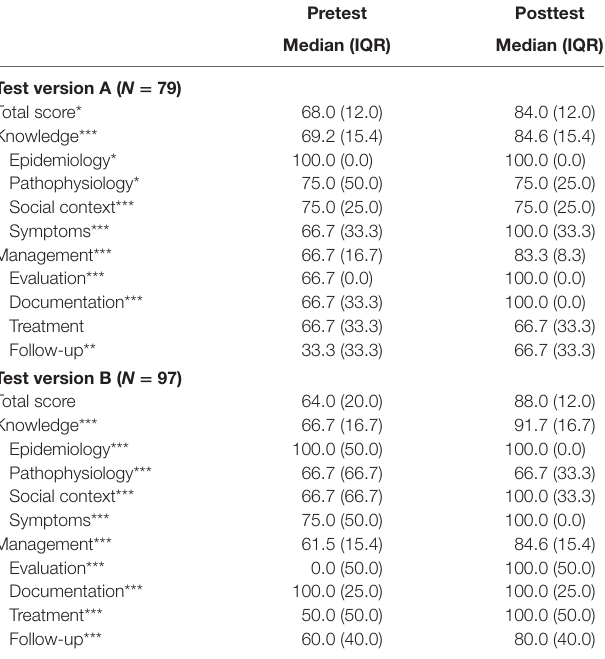
TaBle 2 | Pre- and posttest scores, by domain and subdomain. Pretest